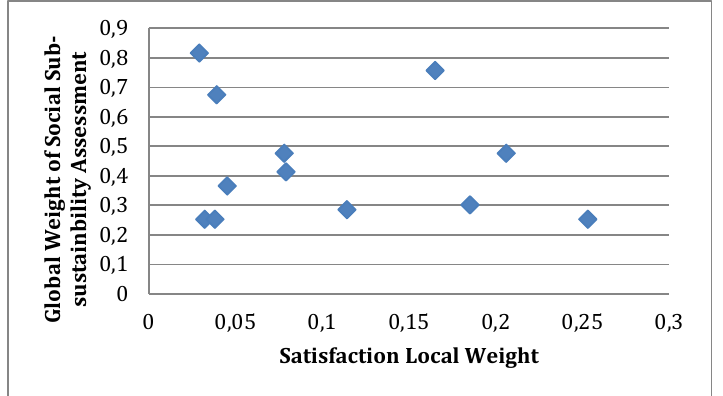
Figure 29: Global weight vs. satisfaction local weight of social sub-sustainability